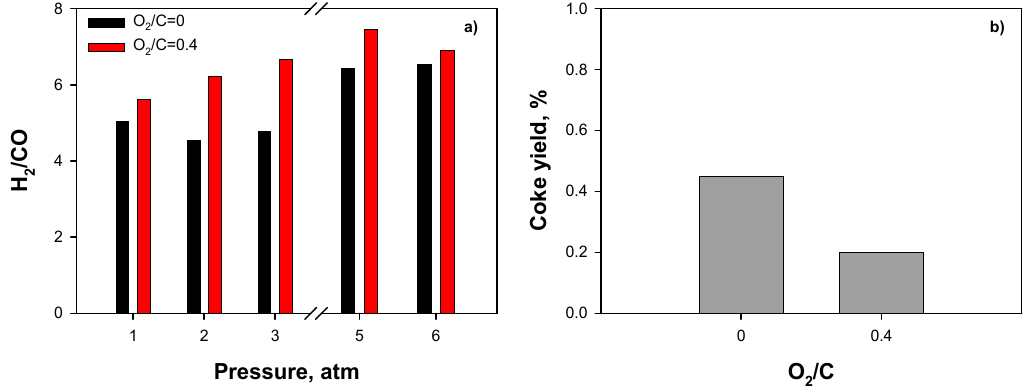
Figure 11. Yields to CO, CH 4, and CO 2 as a function of pressure during steam reforming of AZ mixture on 5 Ni monolith at 720 ◦ C; gas-phase feed composition: Solvent / H 2 O / O 2 / N 2 = 0.7 / 6 / 0 / 93.3 ( a ); 0.7 / 6 / 0.8 / 92.5 ( b ).